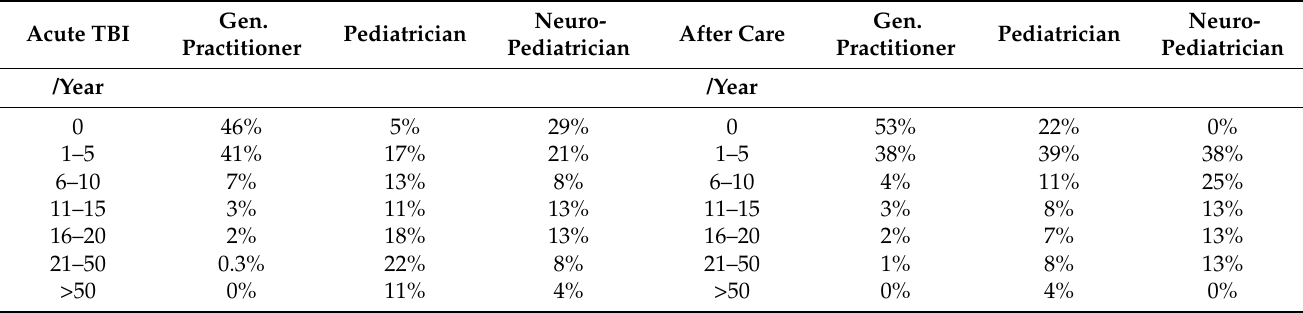
Table 1. Numbers of Patients with acute TBI per year among the different